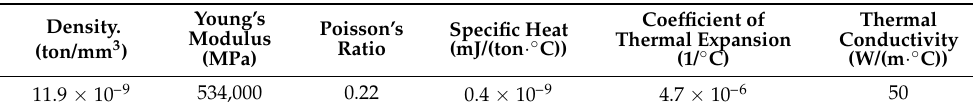
Table 2. The parameters of WC cemented carbide tool (20 ◦ C).